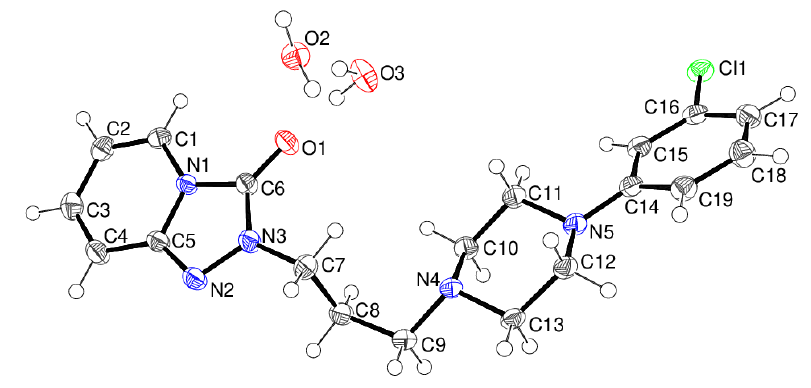
hydrogen-bonded chains propagating in the [10] direction (Figure 3), and weak C-H … N,